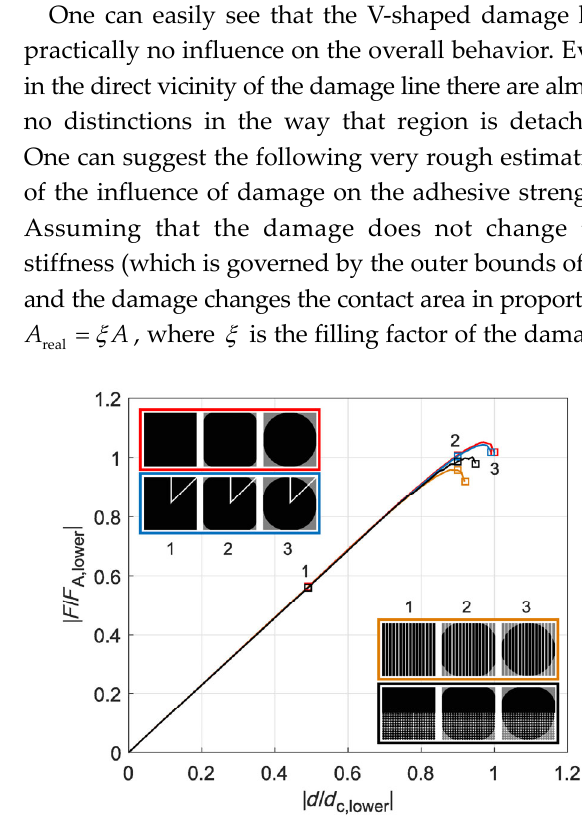
Fig. 7 Contact configurations and force-distance dependencies for a series of squares containing different kinds of faults. The plain square indenter is given as a reference. It is compared with the same square having discontinuities in form of a “V”, a series of vertically oriented line-discontinuities as well as line discontinuities filling only the half of the